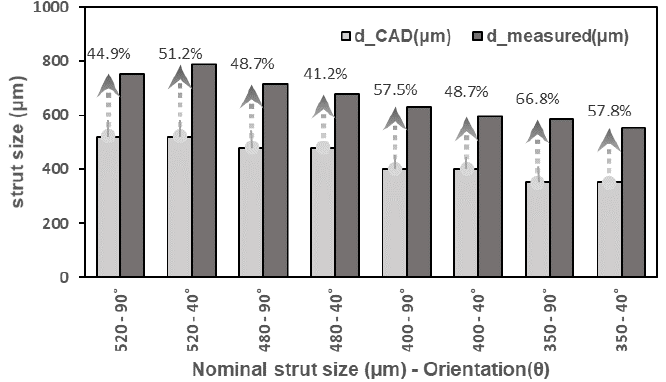
Figure 7. A comparison between the targeted CAD and the average of the measured strut sizes at inclination angles of 40° and 90°.